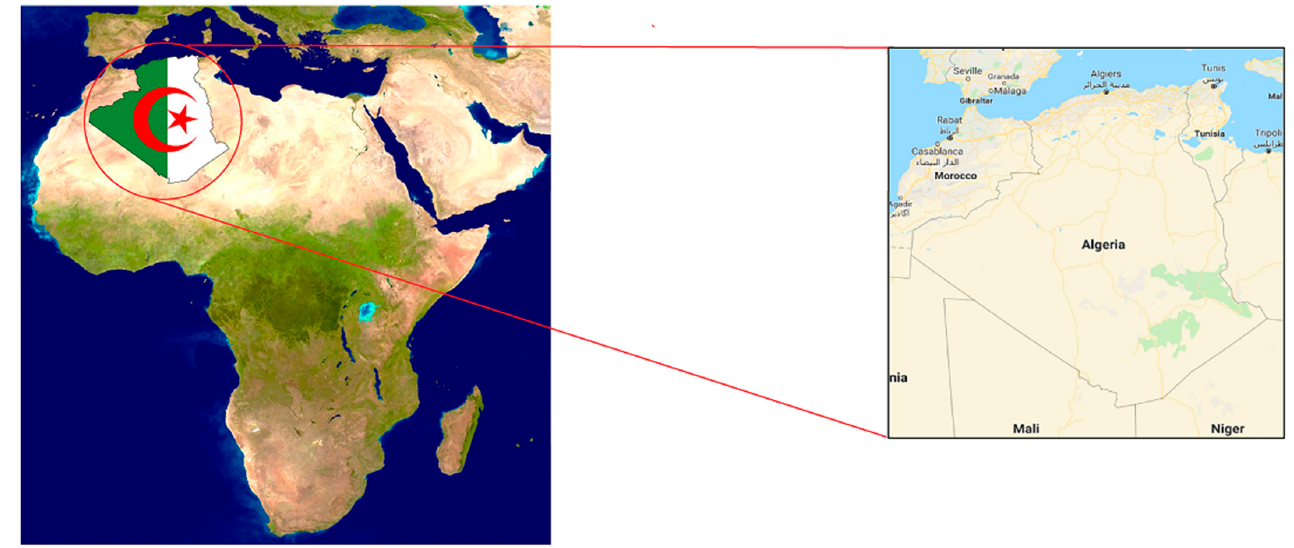
Figure 3. Algeria’s location in Africa.